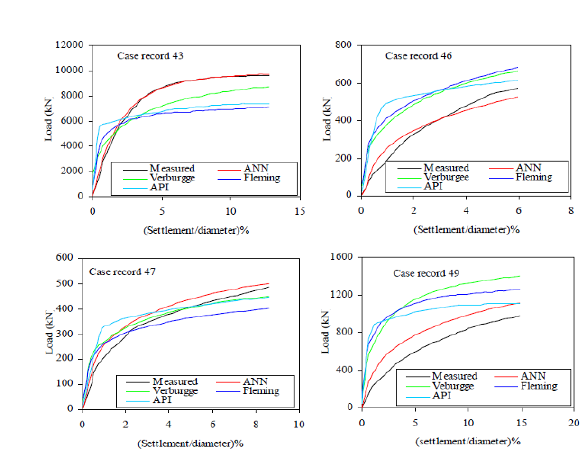
Figure 8. Comparison performance of ANN bored piles model and load-transfer